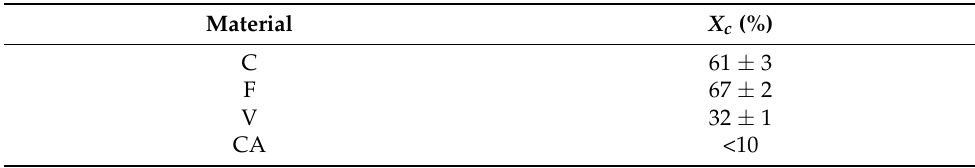
Table 2. Crystallinity index of the